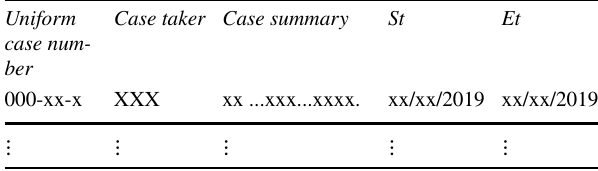
Case taker Case Uniform case num-